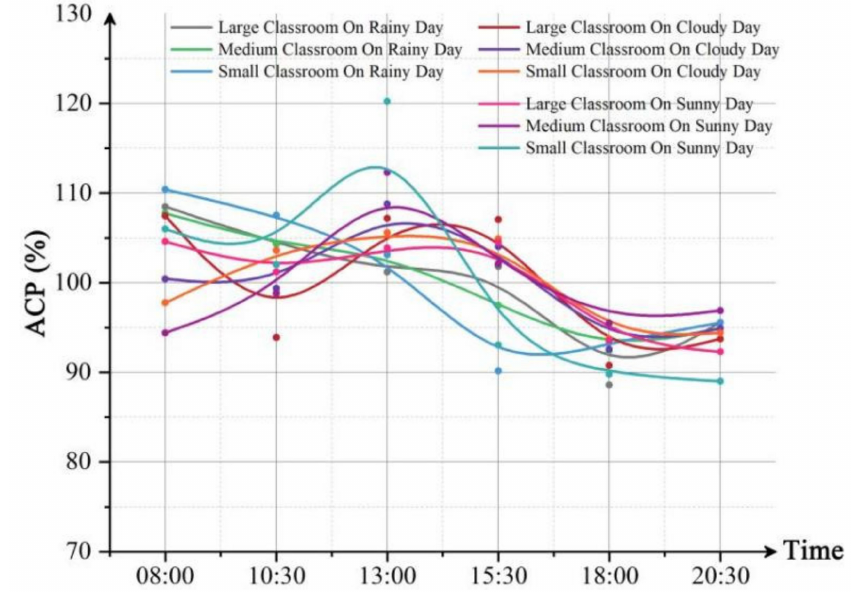
Figure 18. The ACP of the learning efficiency test in the three classroom-types under different weather conditions throughout the day.